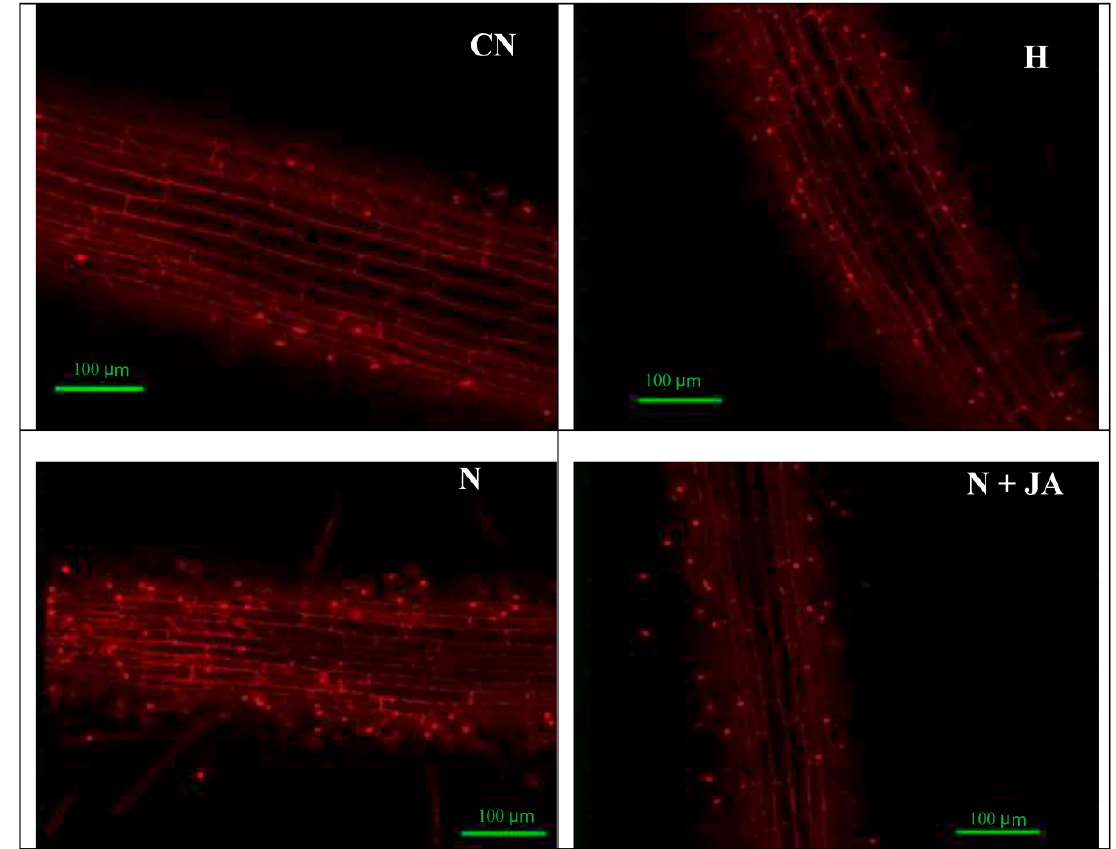
Figure 2. Effect of seed soaking treatment of JA (100 nM) on membrane damage in tomato seedlings after seven days of nematode inoculation. N = nematode, H = 100 nM JA, scale bar = 100 μ m.